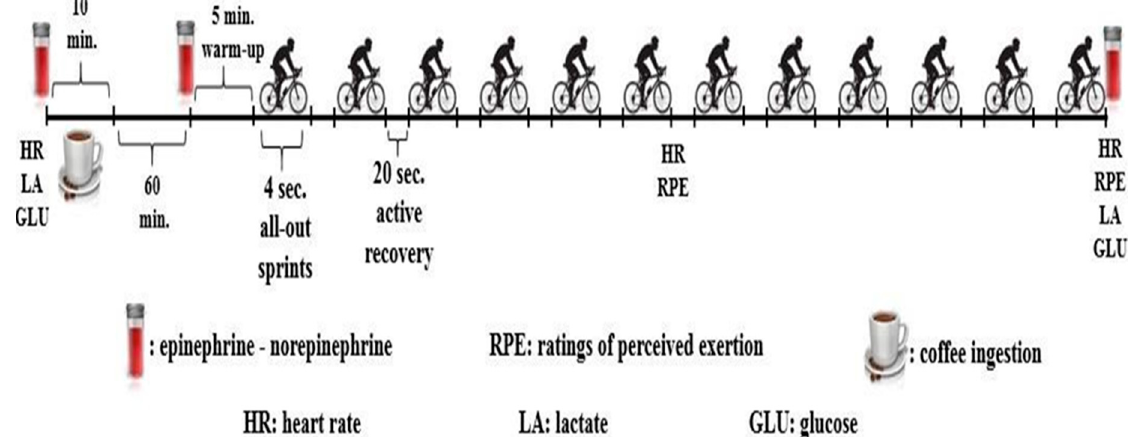
Figure 1. Schematic representation of the repeated sprint test protocol.